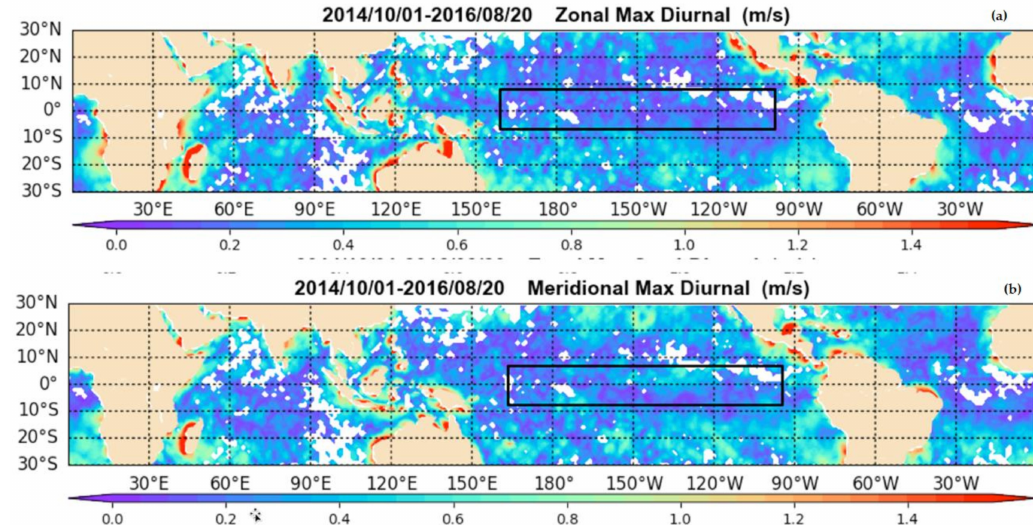
Figure 5. Maps of the maximum amplitude of the diurnal wind components, for all observations meeting the quality control criteria during the RapidScat operations period (October 2014 to September 2016). ( a ) Zonal ( u ) component. ( b ) Meridional ( v )